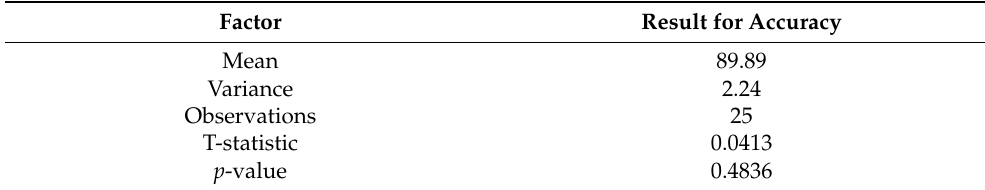
Table 5. Statistical significance results of 25-run 10-fold cross-validation when training and testing MobileNet (v2) using the COVID-19 detection dataset (two classes).